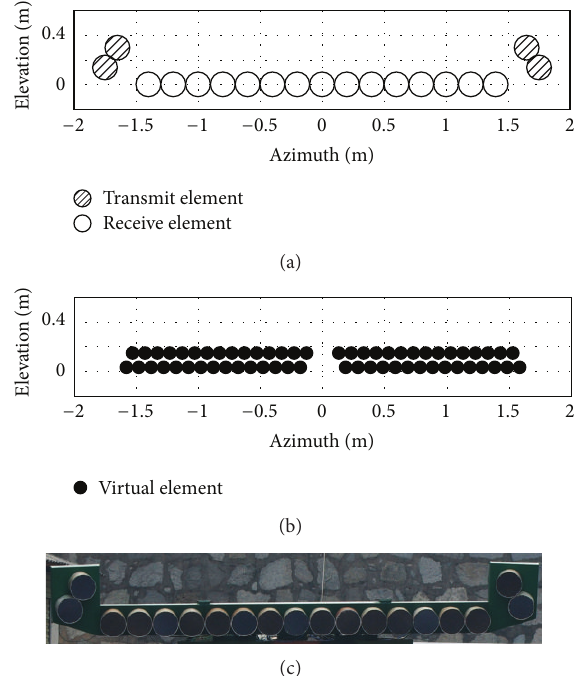
Figure 3: Designed split transmitter virtual aperture array. (a) Topology; (b) equivalent two-way virtual aperture; (c) front view of the of the STVA